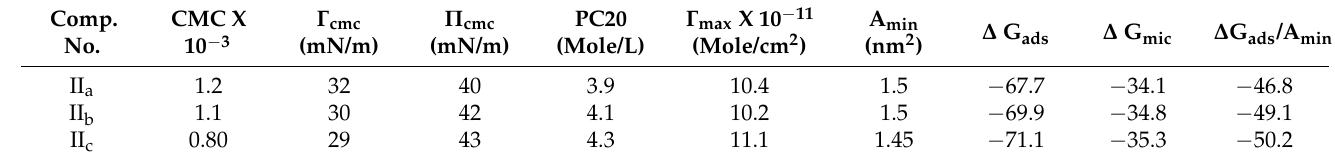
Table 1. The critical micelle concentration (CMC) and surface parameters of synthesized